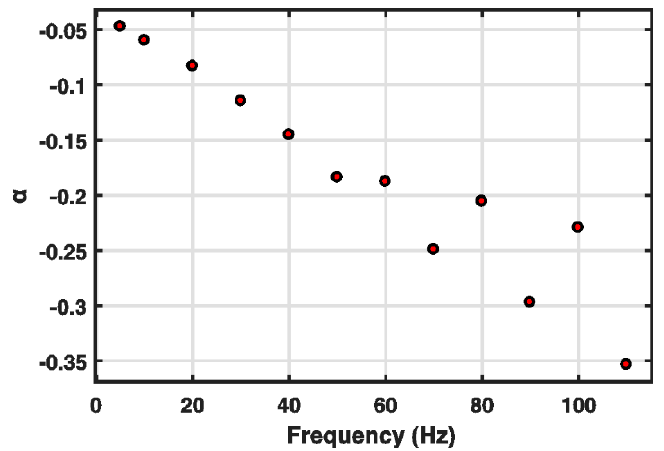
α Figure 2. Variations of under ( ) 5sin(2 ) 5 u t ft π= + at different frequencies. Figure 2. Variations of α under u ( t ) = 5sin ( 2 π ft ) + 5 at different